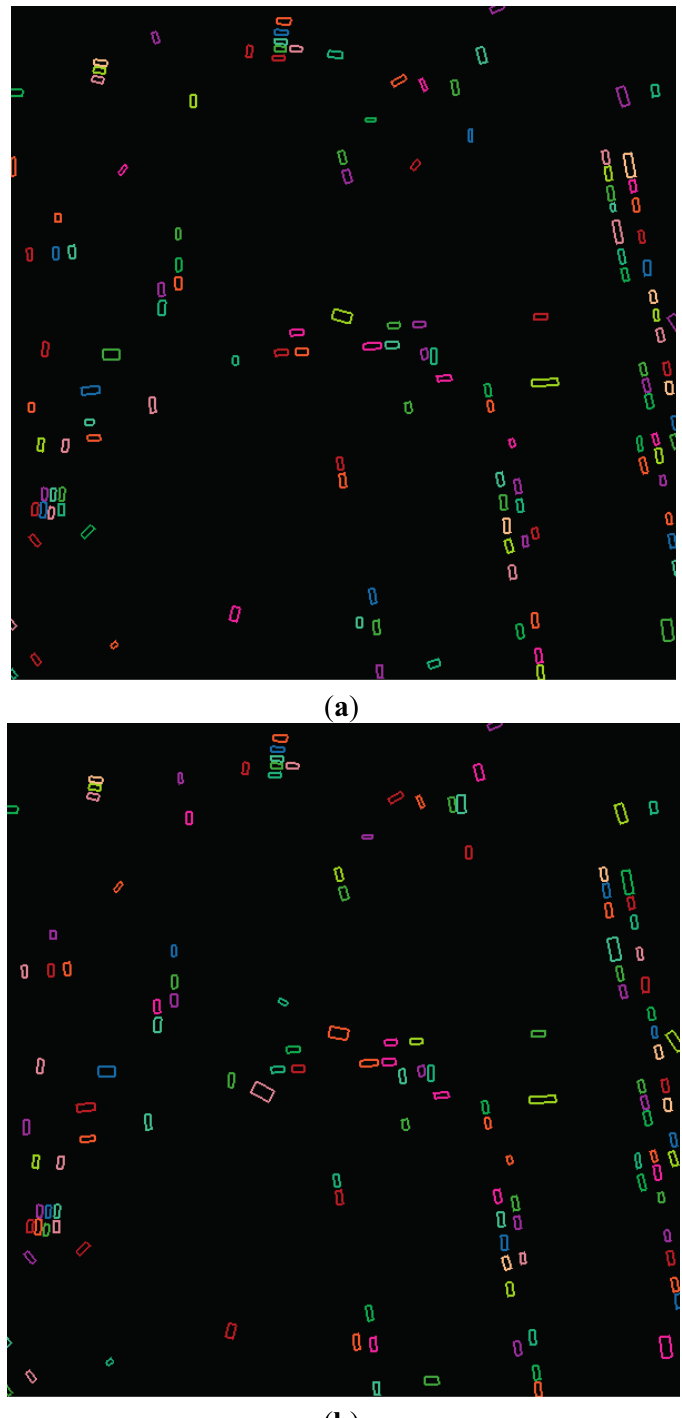
Figure 6. The ground truth data and the vehicles extracted by our proposed method. ( a ) Ground truth data of vehicles generated by human interpretation. ( b ) The extracted vehicles from the point cloud with a point density of 40 points/m 2 . ( c ) The extracted vehicles from the point cloud with a point density of 20 points/ m 2 . ( d ) The extracted vehicles from the point cloud with a point density of 10 points/m 2 . Note that each vehicle is represented as a rectangle, and the corresponding rectangle is drawn with a random color in